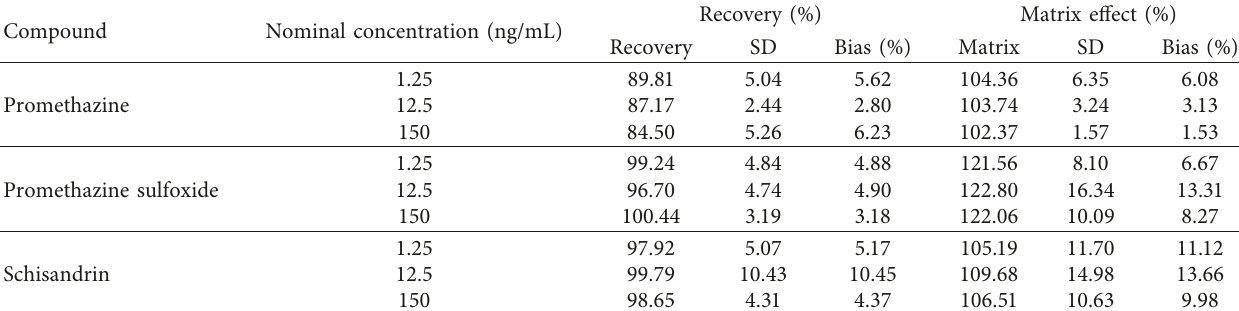
Table 4: Recovery and matrix effect of the three analytes in rat plasma.